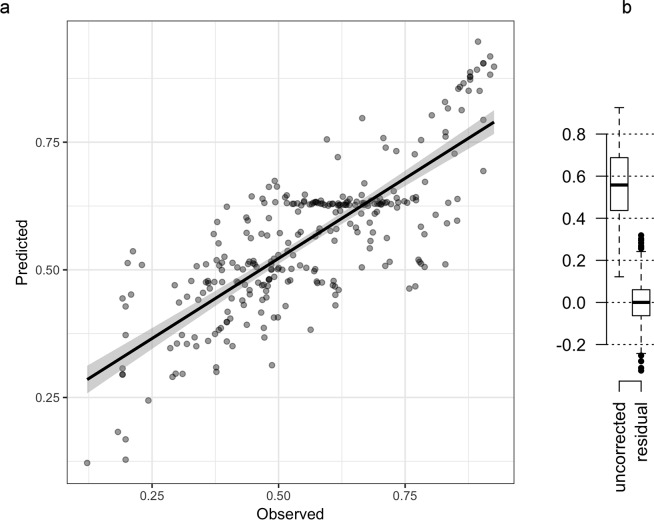
LLMD predicted by a mixed linear model.A mixed linear mixed model (a) constructed using predictors of sampling error rates and continent of sampling explains the majority of human variation in LLMD (Pearson’s r = 0.82; adjusted R2 = 0.57; p < 10−6; N = 280 populations). (b) Correction for these factors eliminates LLMDs in humans. Underlying data can be found in S4 Data. LLMD, late-life mortality deceleration.